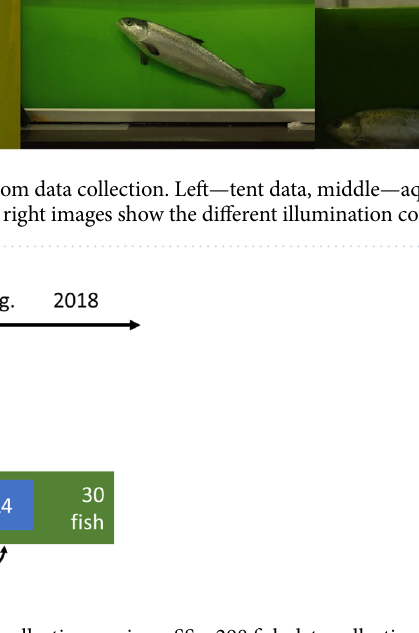
Figure 3. Visualization of data collection sessions. SS—298 fish data collection, SL1, SL2, SL3, SL4—30 tagged fish data collection over the time. The arrows between the SL datasets indicate the identification tasks performed for all combinations of the